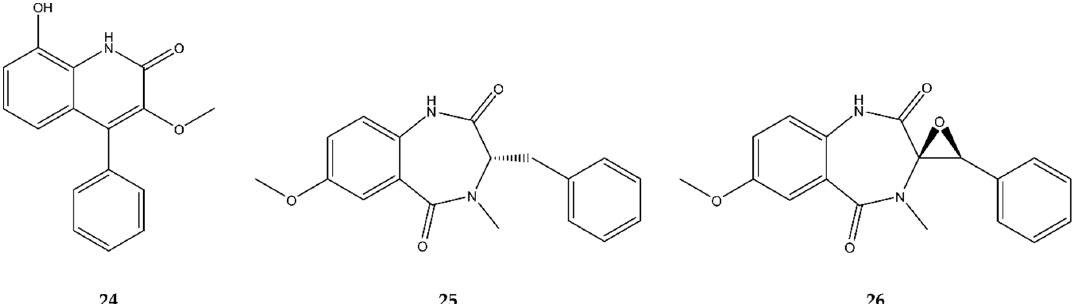
Figure 6. Overview of the different antimicrobial, marine fungal-derived quinoline alkaloids discovered since 2015: 9-hydroxy-3-methoxyviridicatin ( 24 ), 7-methoxycyclopeptin ( 25 ), and 7- methoxycyclopenin ( 26